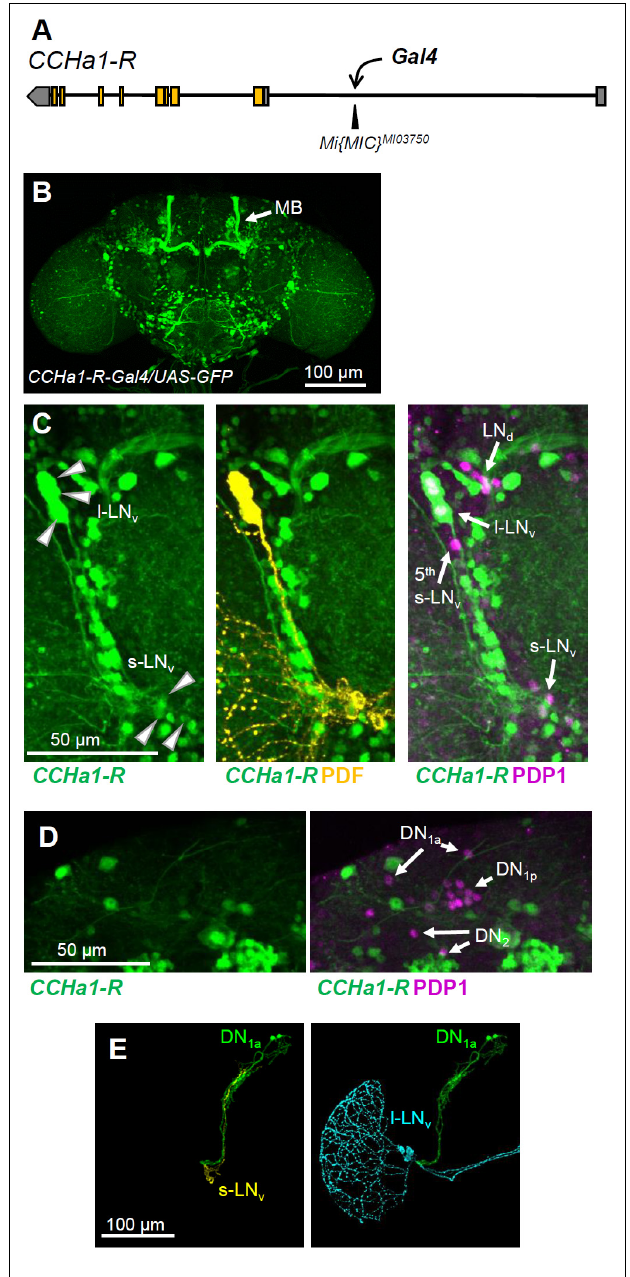
FIGURE 3 | Expression pattern of CCHa1-R in the adult brain. (A) The Gal4 construct was inserted into the 5 (cid:48) -untranslated region of the CCHa1-R gene in the Mi{MIC} MI03750 strain. (B) Immunostaining of the CCHa1-R-Gal4/UAS-GFP strain using an anti-GFP antibody revealed that CCHa1-R is widely distributed in the adult brain, including mushroom bodies (MB, arrow). (C) Triple immunostaining using anti-GFP (green), anti-PDF (yellow) and anti-PDP1 (magenta) antibodies further revealed that CCHa1-R is expressed weakly in the s-LN v and strongly in l-LN v neurons. (D) The DN groups do not express CCHa1-R. (E) Projection patterns of the DN 1a and PDF-positive neurons; the Mi{MIC}CCHa1 MI09190 line, in which the gfp gene trap cassette was inserted into the second exon of the CCHa1 gene, was used to visualize the projections of the DN 1a neurons. The projections of the DN 1a (green), s-LN v (yellow), and l-LN v neurons (light blue) were manually traced and reconstituted using the Fiji plugin Simple Neurite Tracer.